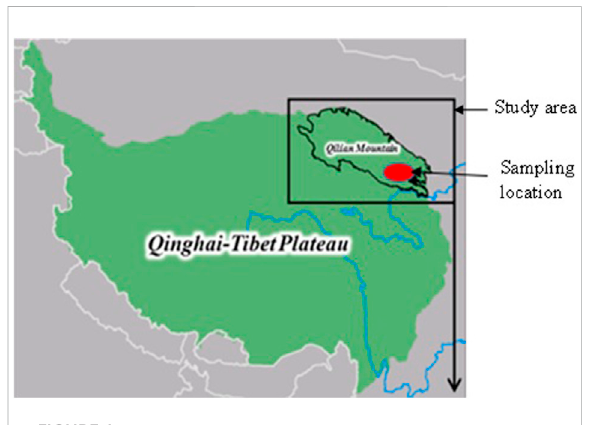
FIGURE 1 Map indicating the study area and sampling location.